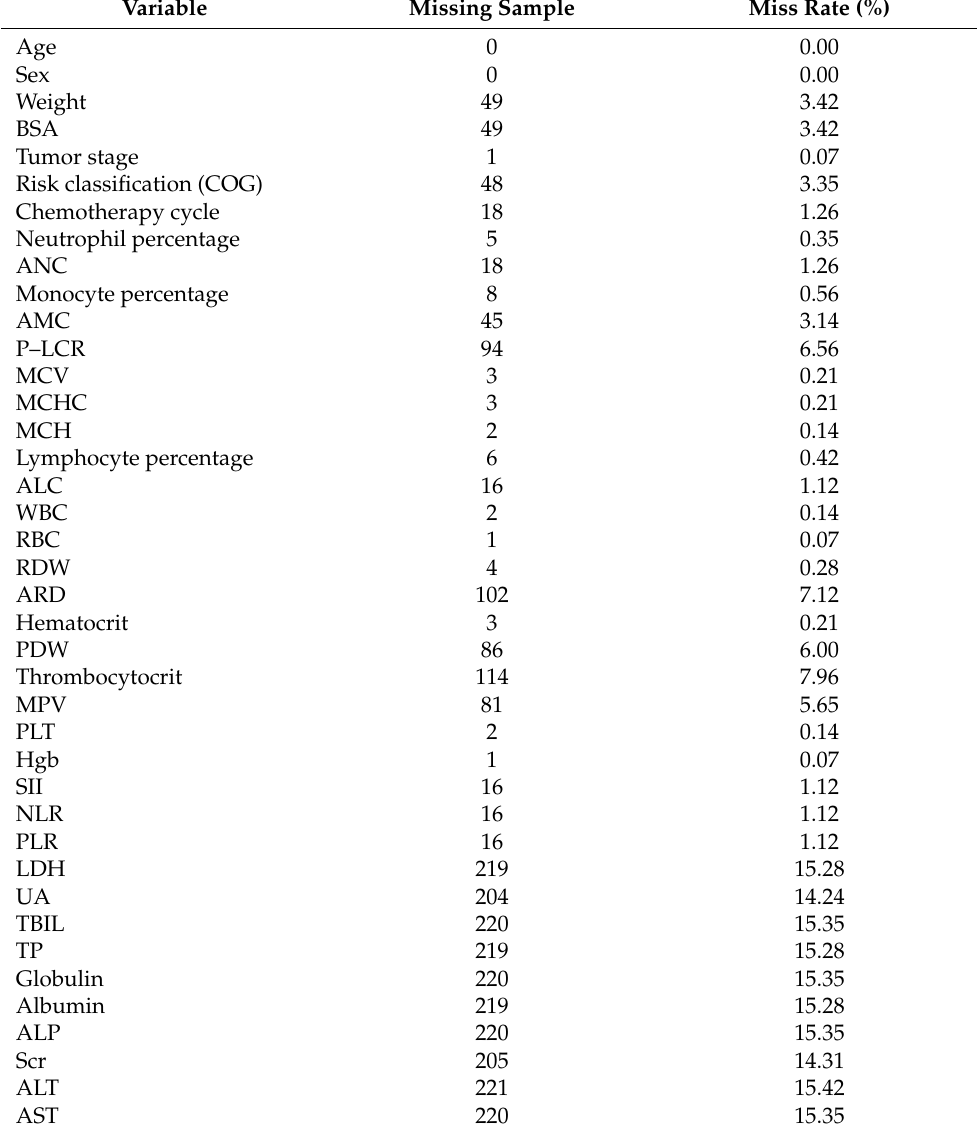
Table 3. 40 clinical characteristic variables to be